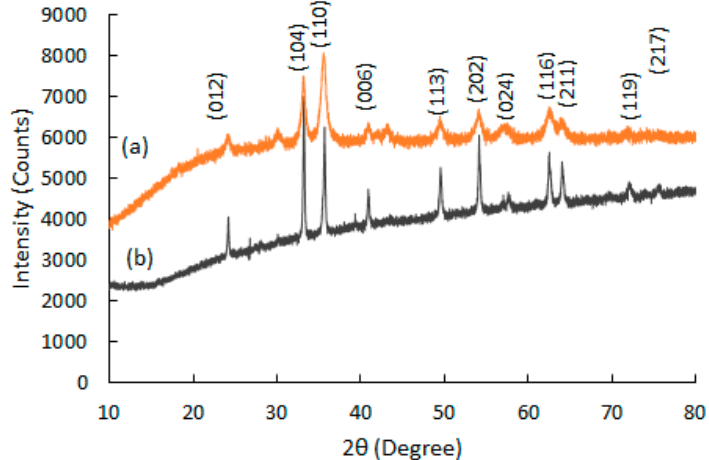
Figure 3. X-ray diffractograms for (a) α -Fe 2 O 3 milled for 12 h ( R wp = 4.09%, Gof = 9.78); (b) unmilled α -Fe 2 O 3 ( R wp = 2.43%, Gof = 2.27).